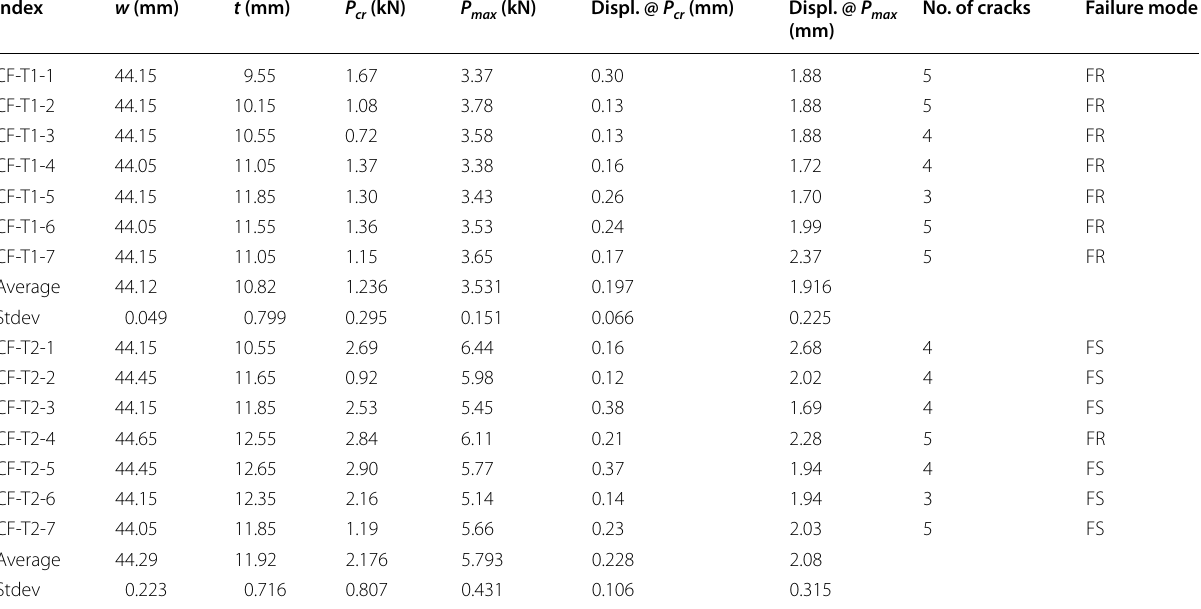
Table 4 Summary of tensile test results: CF 1 layer and CF 2 layers.